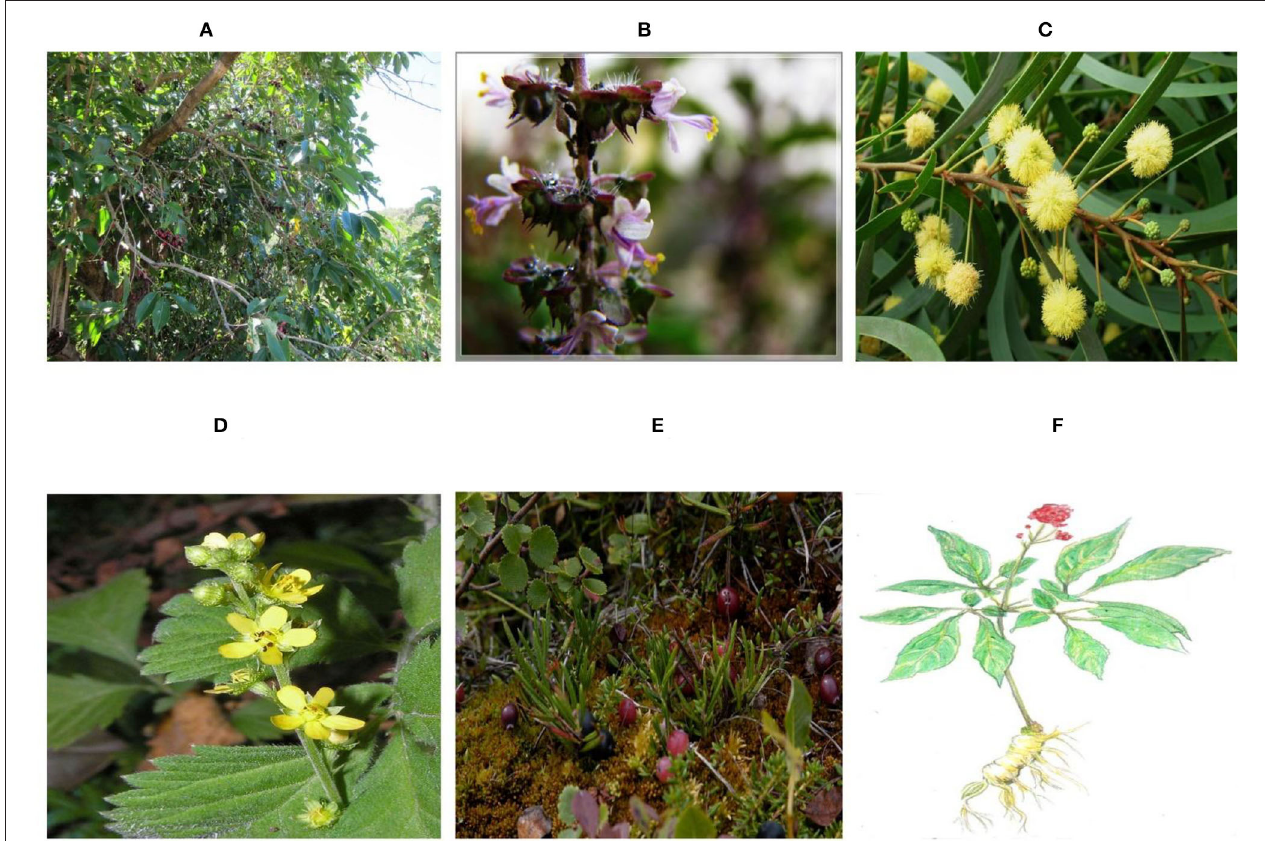
FIGURE 4 | Plants in therapeutics to control avian infectious influenza. (A) Eugenia jambolana (99). (B) Ocimum sanctum (100). (C) Acacia Arabica (101). (D) Agrimonia pilosa (102). (E) cranberry (103), and (F) Ginseng (104).